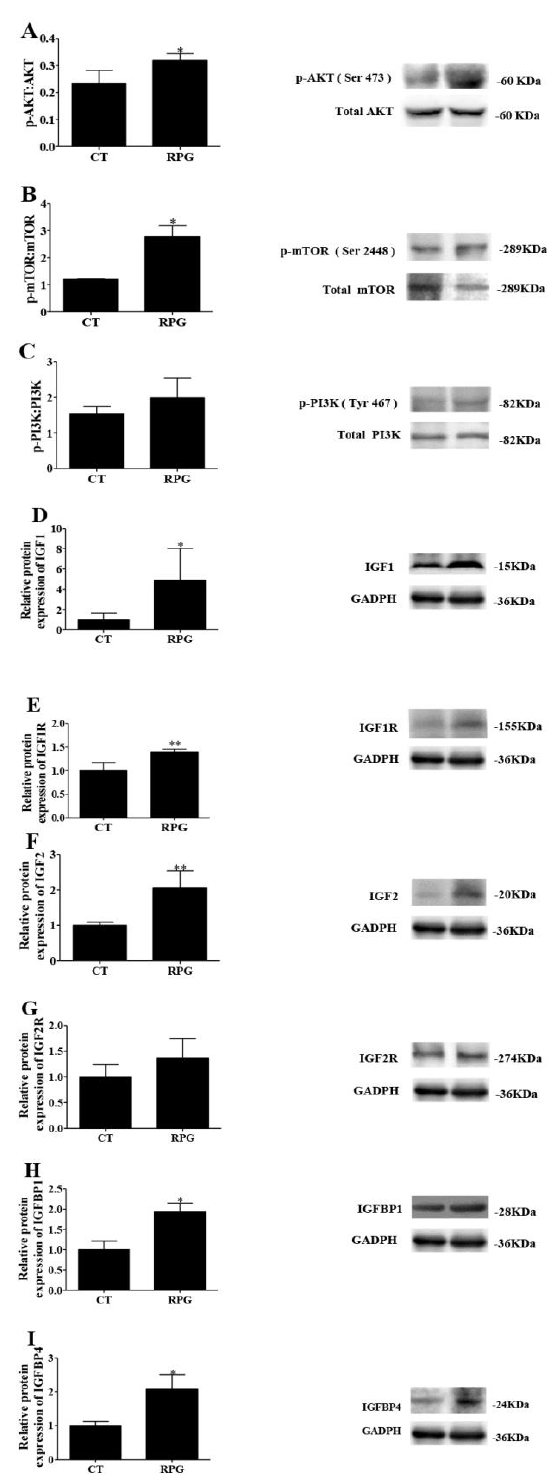
Figure 4. Immunoblotting results for phosphorylated proteins and IGF family members protein expression in uterine tissue from the post-natal cows fed with RPG supplementation and the control diet (CT) during the experimental period. Least squares geometric means of the ratio of phosphorylated (p) protein kinase B (AKT; Ser473): AKT ( A ), p-mechanistic target of rapamycin complex 1 (mTOR, Ser2448): mTOR ( B ), p-phosphatidylinositol 3-kinase (PI3K, Tyr 467): PI3K ( C ), IGF1 ( D ), IGF1R ( E ), IGF2 ( F ), IGF2R ( G ), IGFBP1 ( H ) and IGFBP4 ( I ) proteins are presented. Data are presented as the means ± SD. * p < 0.05, ** p < 0.01.